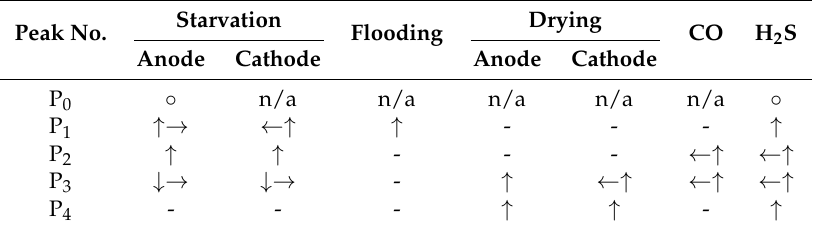
Table 3. Peak changes for the different operating conditions. The peaks are counted from P 0 at the lowest frequency to P 4 at the highest frequency. ◦ indicates the presence of a peak without data for its changes; n/a indicates the absence of a peak; - indicates no changes; and the arrows indicate the direction of changes compared to less faulty